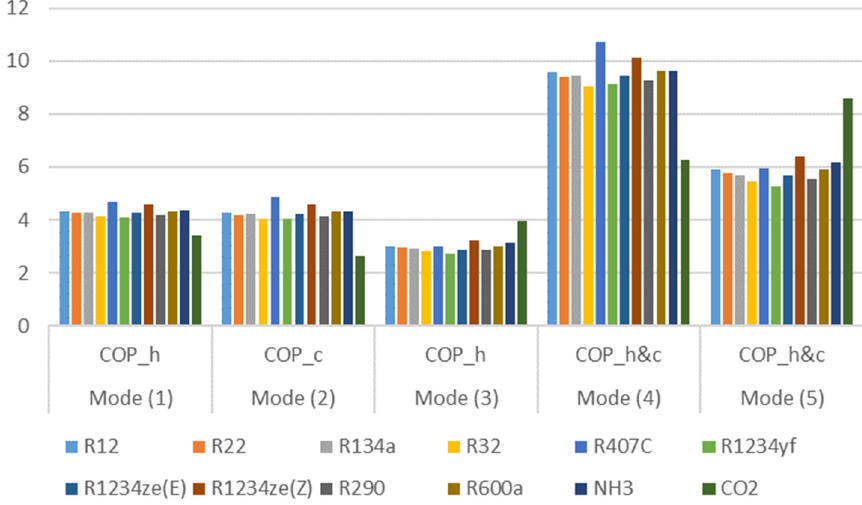
Figure 12. Comparison of cycle COPs in different operating modes.